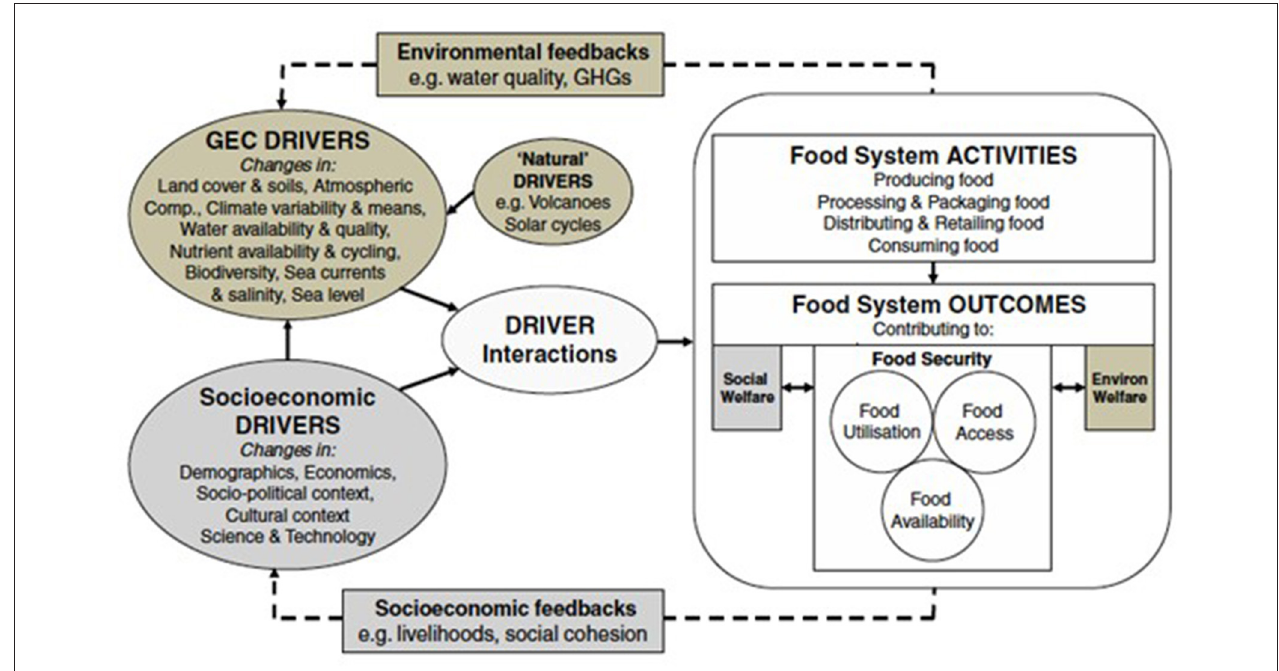
FIGURE 1 | A framework for food systems research emphasising Drivers, Activities, and Outcomes (Ingram, 2011, p.